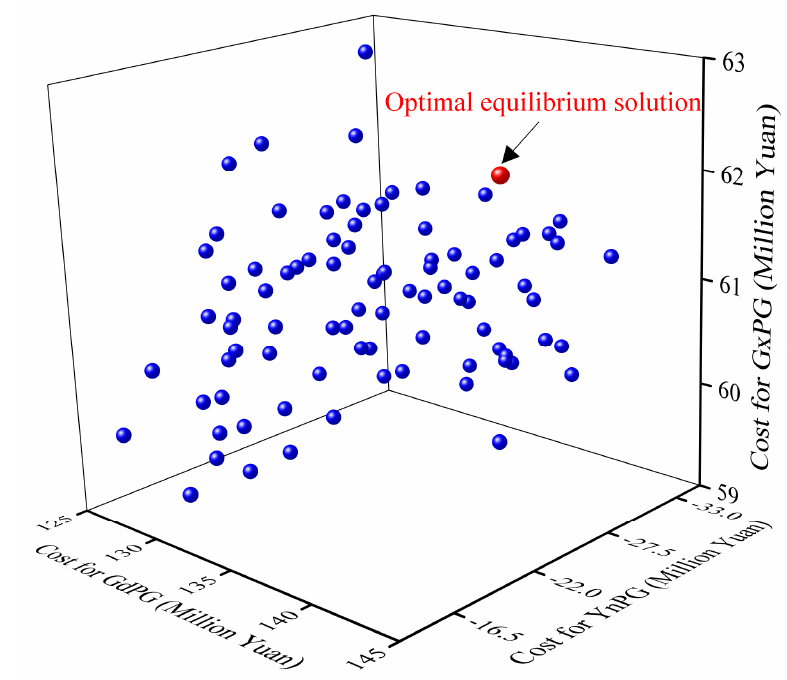
Energies 2021 , 14 , x FOR PEER REVIEW Figure 4. Approximate Pareto front composed of non-dominated solutions. Figure 4. Approximate Pareto front composed of non-dominated solutions.